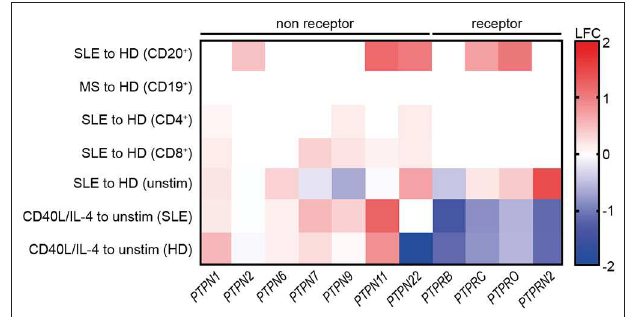
FIGURE 6 | Common reduction of receptor-type PTP expression upon co-stimulation with CD40L/IL-4. Differential expression of selected genes related to receptor-type and non receptor-type PTPs in SLE vs. HD CD20 + B cells (6 SLE, 7 HD), MS vs. HD CD19 + B cells (10MS, 10 HD), SLE vs. HD CD4 + (53 SLE, 41 HD), and CD8 + T cells (22 SLE, 31 HD) (lines 1–4 are from publicly available data). Differential gene expression from un-stimulated SLE vs. HD and CD40L/IL-4 stimulated for SLE vs. un-stimulated SLE or HD CD19 + B cells, respectively [n(HD/SLE) = 1/2], (lines